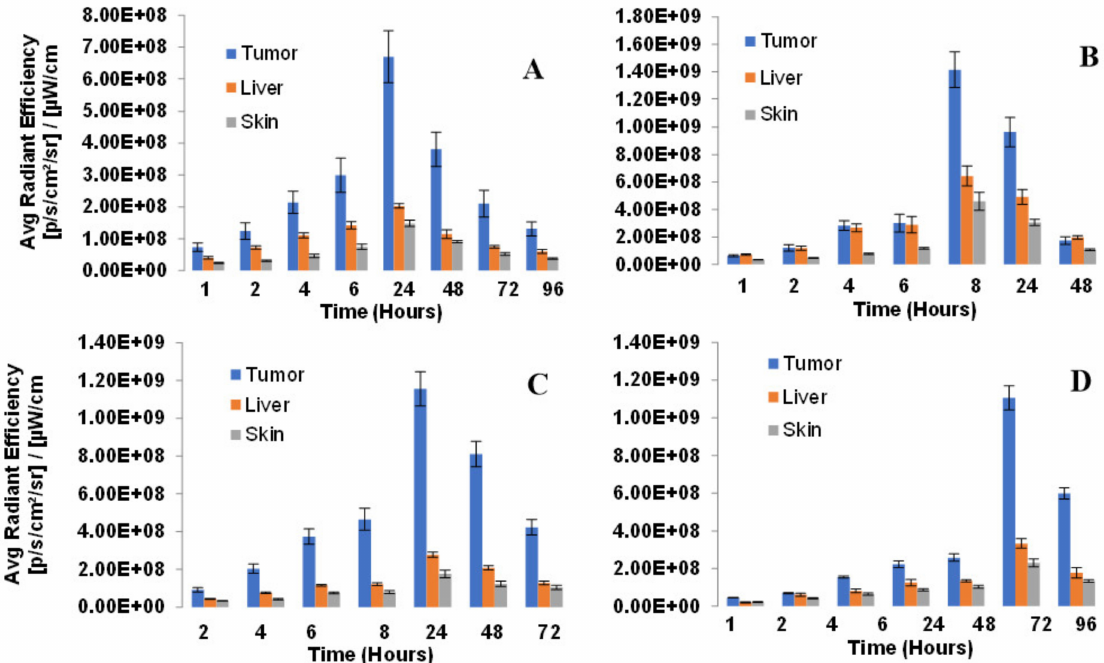
Figure 8. Biodistribution of PS in lung PDX models: ( A ) NSCLC148070, ( B ) NSCLC 0229047, ( C ) SCC 14541 and ( D ) Lung Adenocarcinoma 15021. SCID mice (3 mice/group) were implanted with lung xenografts on the right flank. Tumors were grown until reaching approximately 5 mm diameter. PS 1 (formulated in 2% Pluronic F-127, at a dose of 0.47 µ mol/kg was administered retro-orbitally (alternate for tail vein injection). Tumor, liver and skin uptake was measured by an IVIS Spectrum using Living Image acquisition and analysis software at 2, 4, 6, 8, 24, 48 and 72 h. Excitation and emission filters were 640–660 nm and >720 nm respectively. In all tumor types, the maximum uptake was observed at 24 h post-injection of the